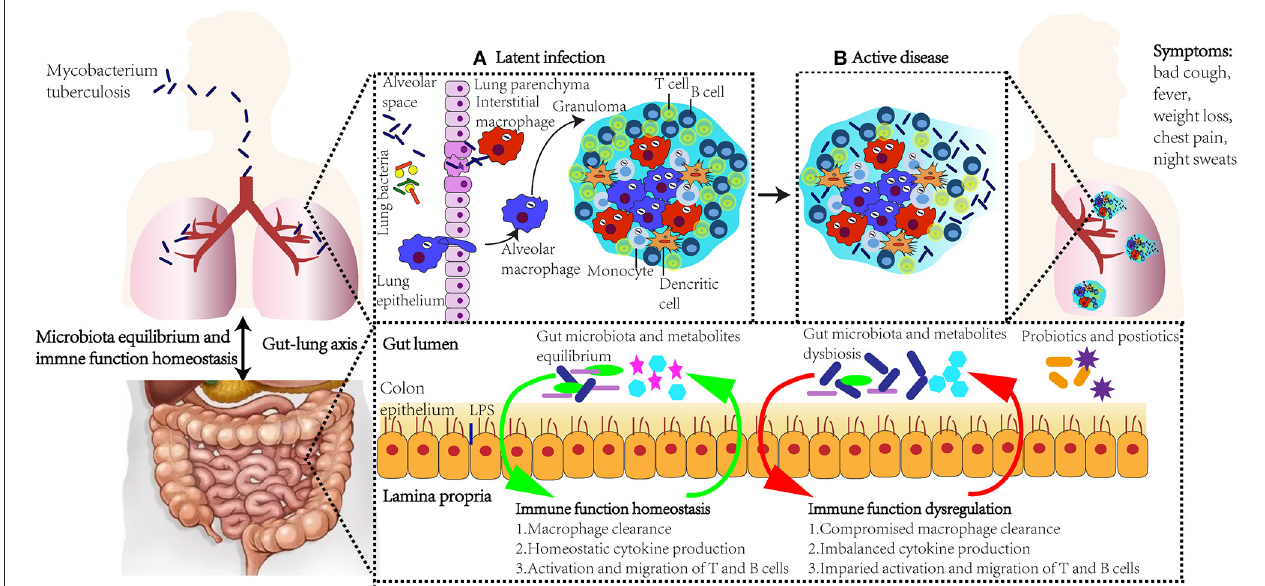
FIGURE 1 | The role of immune response, gut microbiota, lung microbiota, and gut–lung axis in M. tuberculosis infection. Upon exposure to M. tuberculosis , alveolar epithelial cells are the first cell lines to recognize and bind to the outer surface molecules of the mycobacteria. Immune cells, including macrophages and T and B cells, migrate to infection sites, form granulomas around M. tuberculosis , and restrict its replication (A) . However, when granulomas are impaired due to factors, such as HIV infection, smoking, aging, and malnutrition, M. tuberculosis escape from granulomas and spread to other tissues (B) . Active TB patients show symptoms such as bad cough, fever, weight loss, chest pain, and night sweats. The gastrointestinal tract and lung influence the microbiota and immune function homeostasis of each other, and this bidirectional gut-lung axis consequently influences the host immune response against M. tuberculosis . Novel supplementation, such as probiotics and postbiotics, could modulate microbiota and regulate immune function, and be applied as strategies in TB prevention and